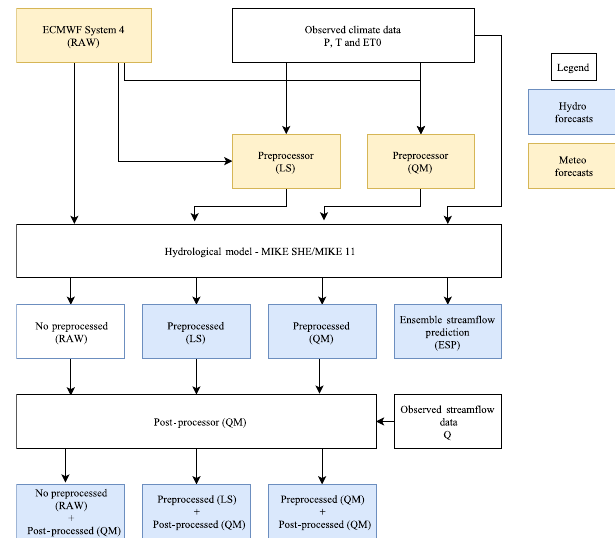
Figure 1. Diagram of generation of forecasts and verification proce- dures. RAW refers to the uncorrected ECMWF System 4 forecasts, while LS and QM refer to forecasts (either meteorological or hydro- logical) that are corrected using the linear scaling/delta change or quantile mapping method, respectively, for precipitation ( P ), tem- perature ( T ) and reference evapotranspiration ( E T 0 ). Preprocessed refers to streamflow forecasts generated using corrected meteoro- logical forecasts while post-processed refers to corrected stream- flow